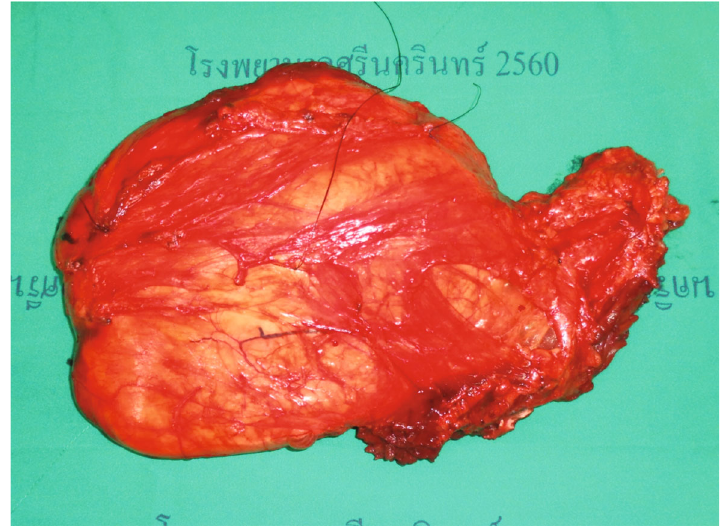
Figure 1: Specimen of soft tissue tumor (the primary tumor) after wide resection.